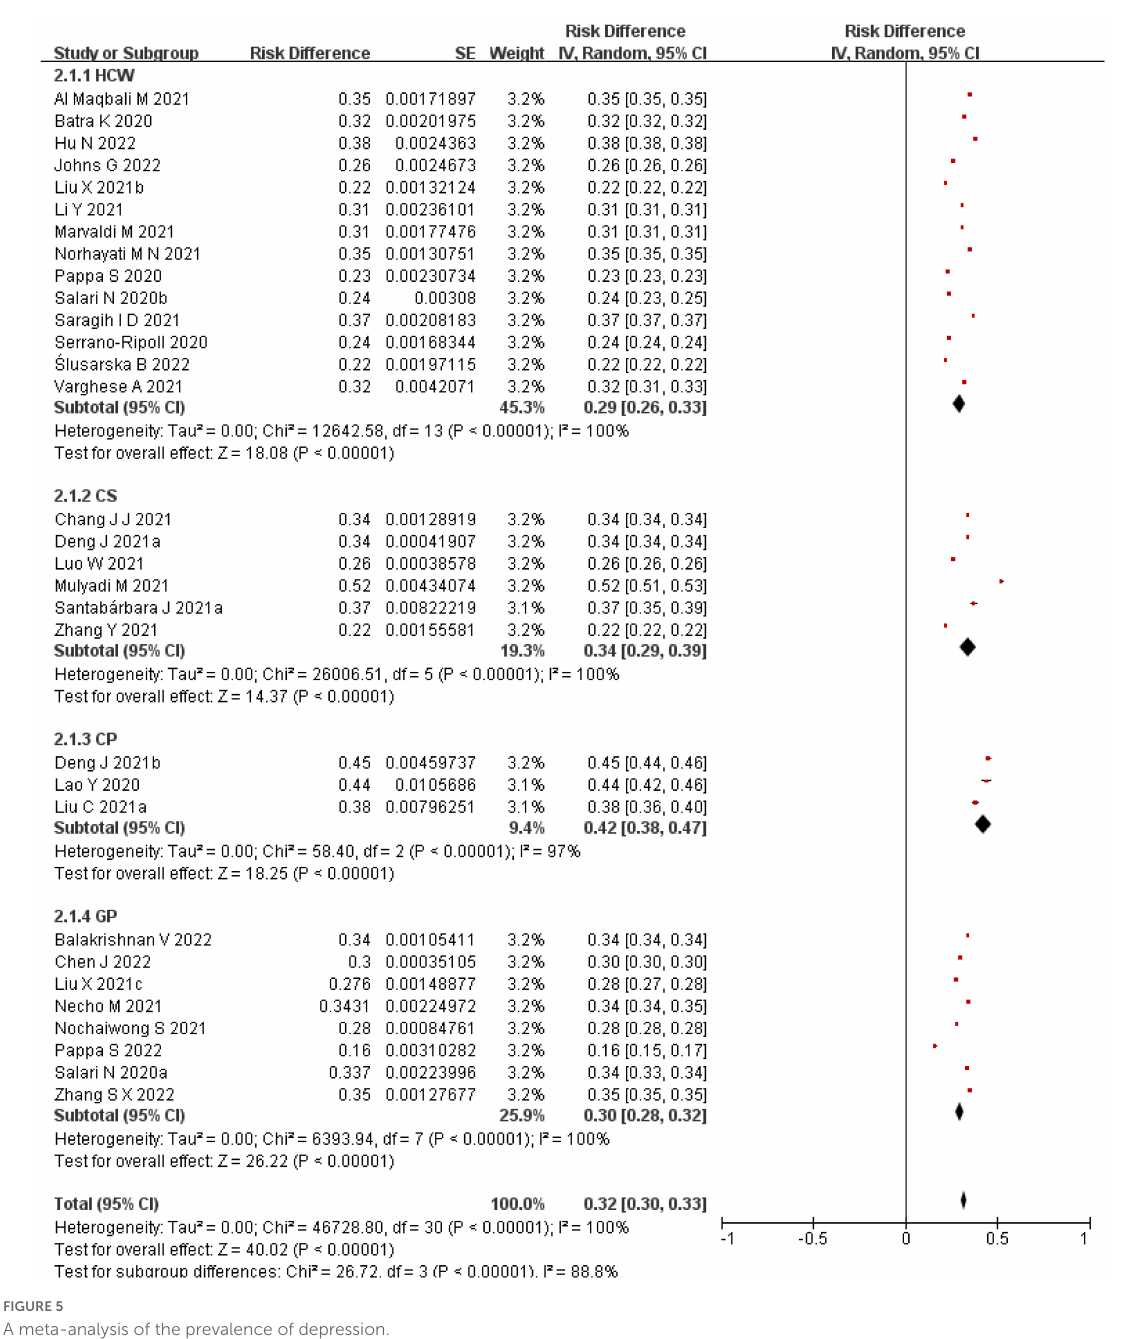
with the COVID-19 are filled with internal panic and fear for their lives (Gyasi, 2020), the lack of contact with the outside world during isolation or hospitalization, which makes